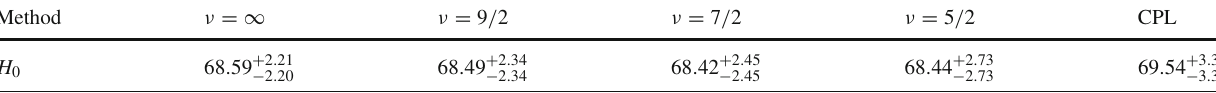
Table1 Averagevaluesof H 0 fordifferentGPkernelsvs.theCPLdark energy model. These results are based on 300+ mock flat Λ CDM real- isations of forecasted DESI data through a process explained in